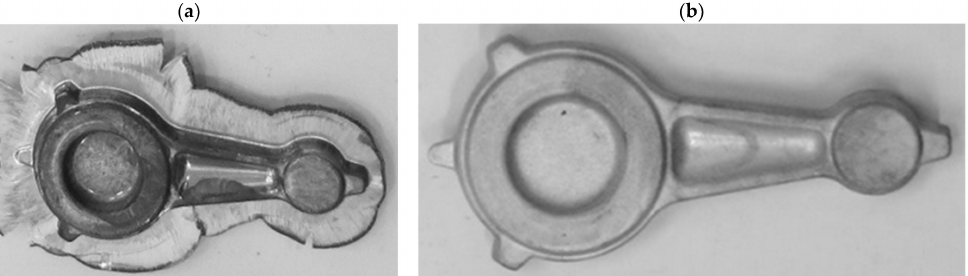
Figure 23. Forgings of connecting rods made of AB-71100 aluminum alloy obtained in the process of forging on a screw press from a cast preform in accordance with variant 1 ( a ); trimming the flash and etching after the process ( b